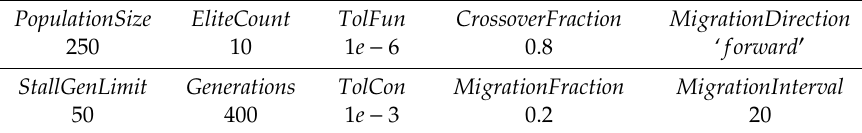
Table 1. Settings and parameters adopted for the Genetic